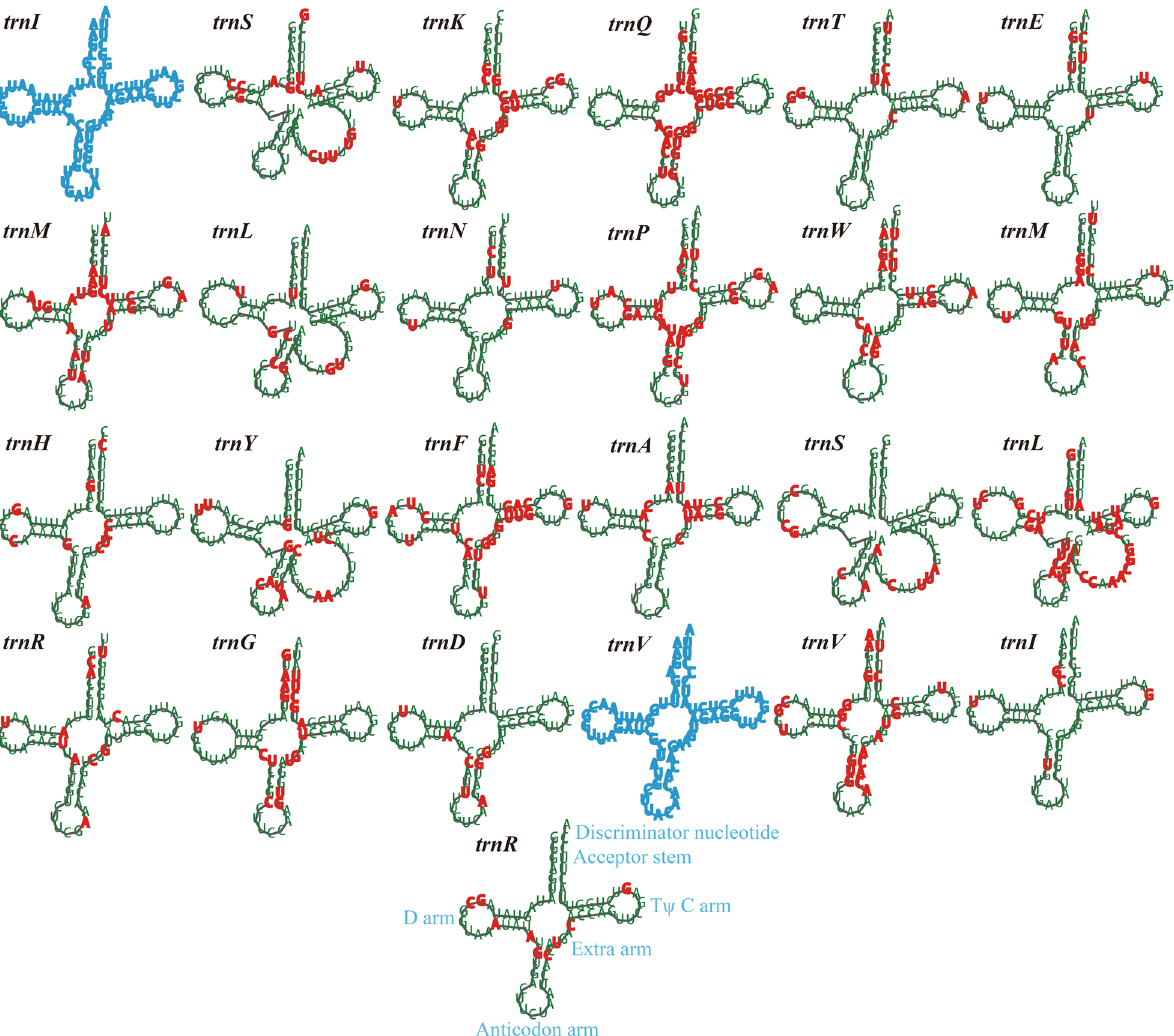
Fig. 2 Putative secondary structures of tRNA genes identified in the mitogenomes of two Apiotrichum species. The 23 tRNAs in green or red fonts represent tRNAs shared by the two Apiotrichum species, while the tRNA in blue font represent tRNA only in A. gracile . Residues conserved across the two mitogenomes are shown in green, while variable sites are shown in red. All genes are shown in order of occurrence in the mitochondrial genome of A. gracile starting from